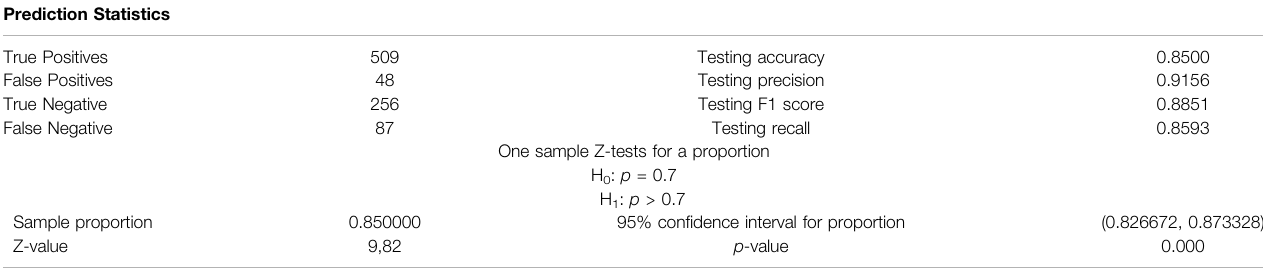
TABLE 2 | Prediction statistics and hypothesis test of for RNN model classi fi er for classifying negative OCRs from non-negative OCRs. Prediction Statistics